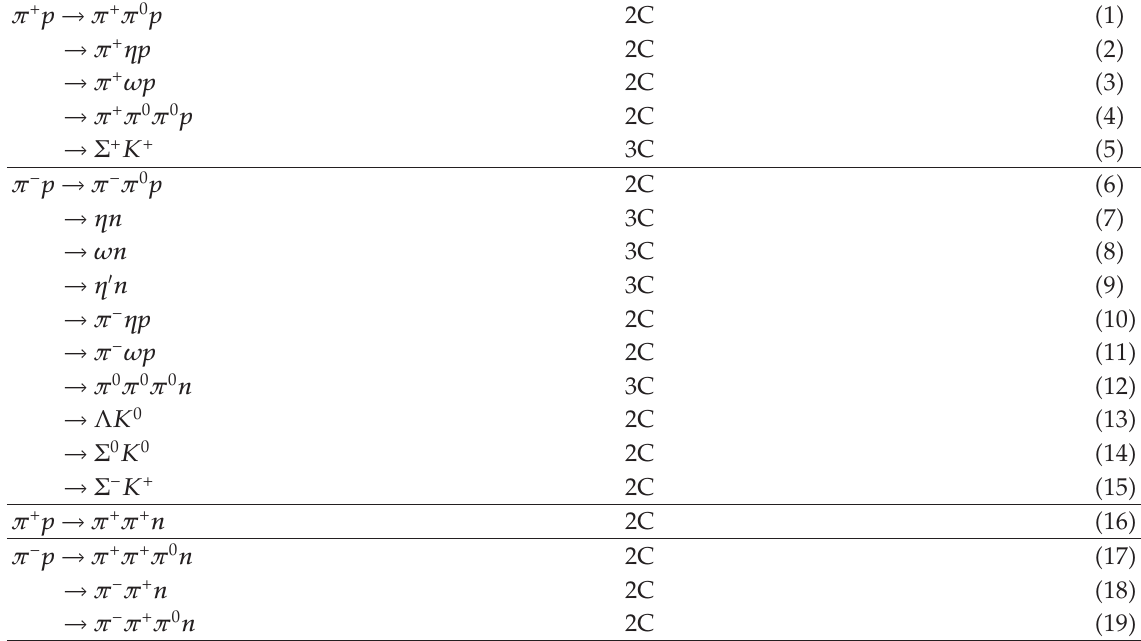
Table 1: Easy channels for baryon spectroscopy; the upper part of the table assumes particle momenta are unmeasured; the lower part assumes neutron time-of-flight is